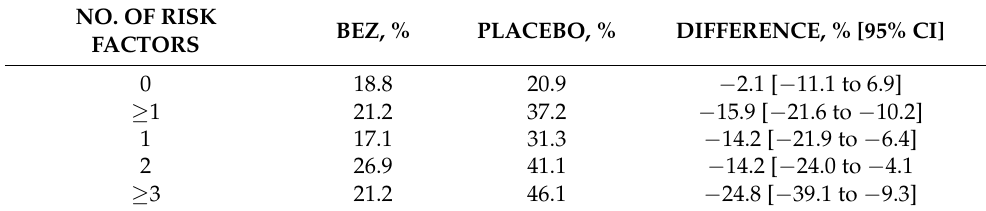
Table 3. Rates of rCDI according to number of prespecified risk factors [34]. NO. OF RISK BEZ, % PLACEBO, % DIFFERENCE, % [95% CI] FACTORS 0